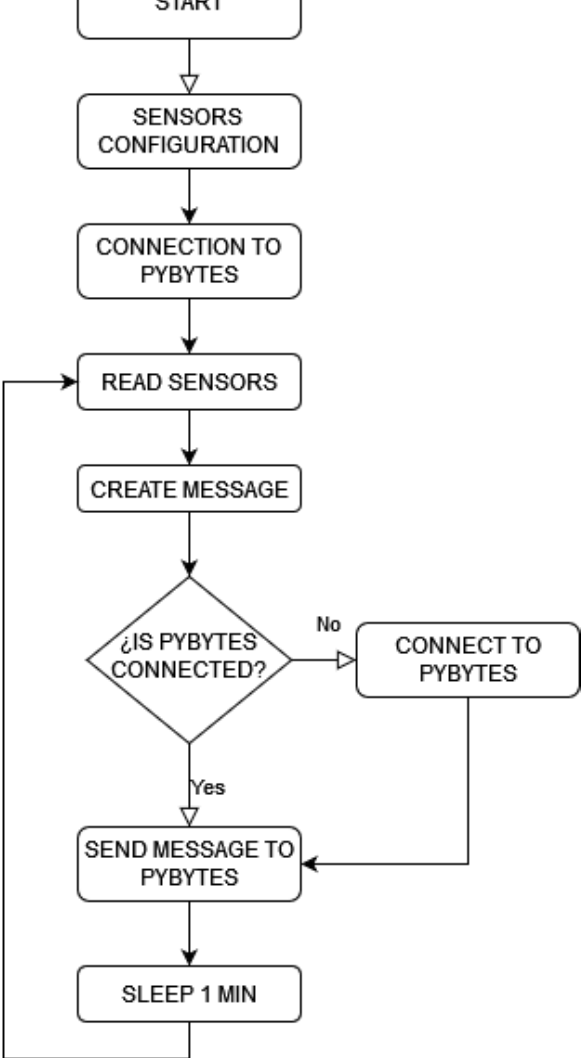
Figure 1. Flow diagram for the